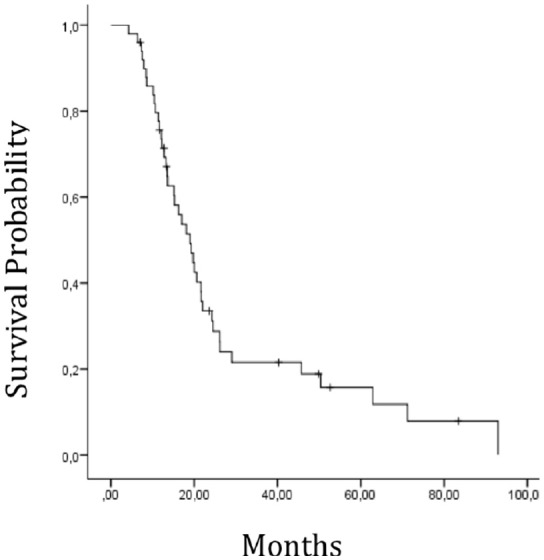
Overall survival for the entire cohorte.